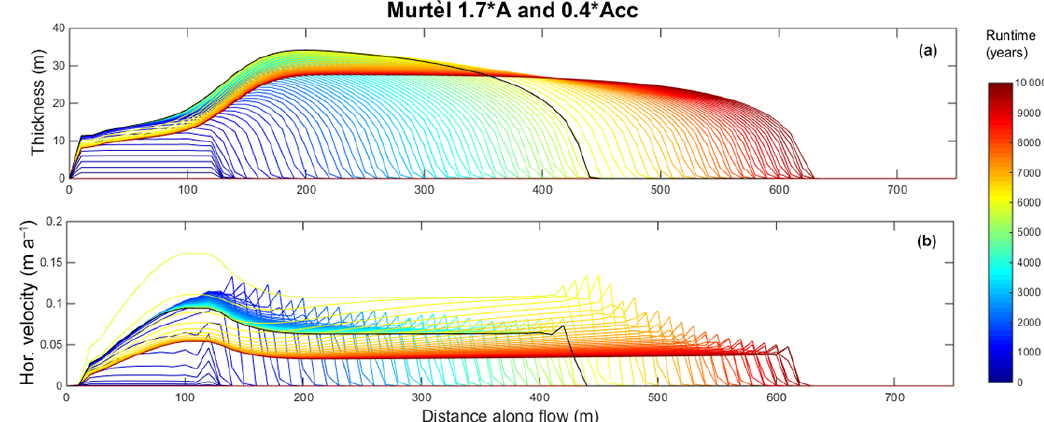
Figure 8. Modeled evolution of absolute thickness (a) and horizontal velocities (b) of the Murtèl rock glacier introducing a 1 ◦ C temperature increase (1.7 times increase in rate factor) and a reduction in material input to 40% after the rock glacier buildup (6000a, black line). The black lines in all plots depict the state of the rock glacier as shown in Fig. 5 before the perturbations were introduced. The lines are plotted at 100a time steps.